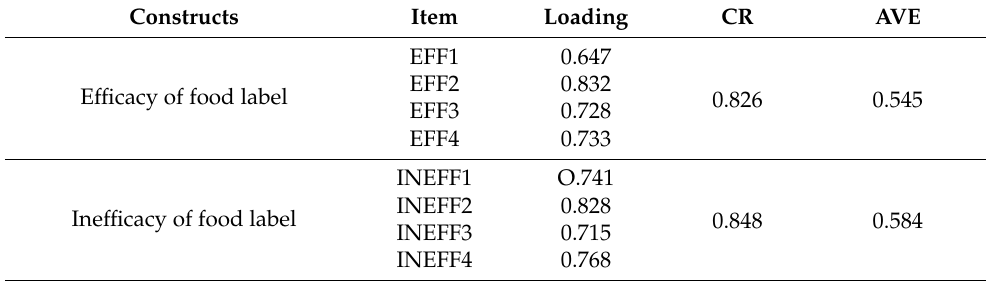
Table 3. Measurement model